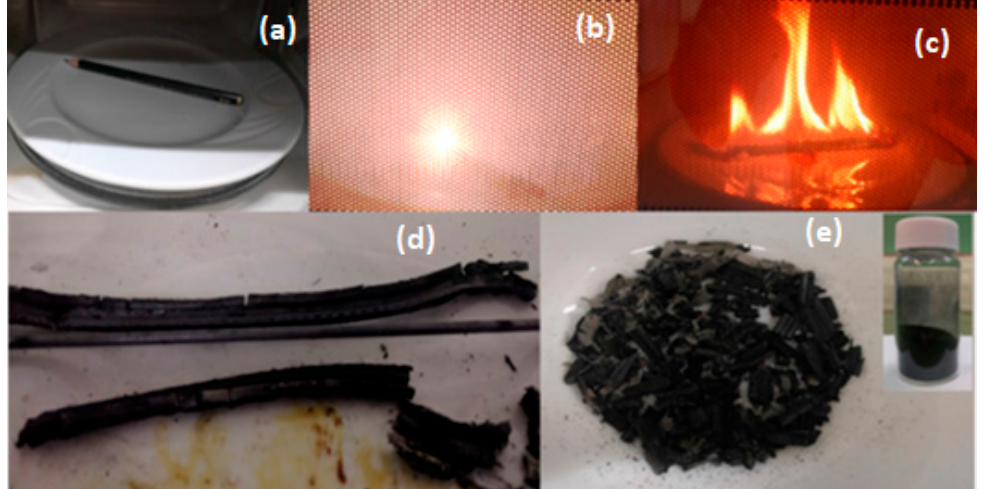
Figure 1. A wood pencil on a ceramic plate was placed in the microwave oven ( a ) and irradiated for a couple of minutes at 700 W under rotation ( b ). The graphite core produced hot plasma, igniting the pencil ( c ). After that, the graphite lead and the carbonized wood casing were spontaneously split from each other ( d ). The carbonized wood specimens were collected and acid-treated to finally afford a fine carbon powder, codenamed PC (inset glass vial) ( e ).